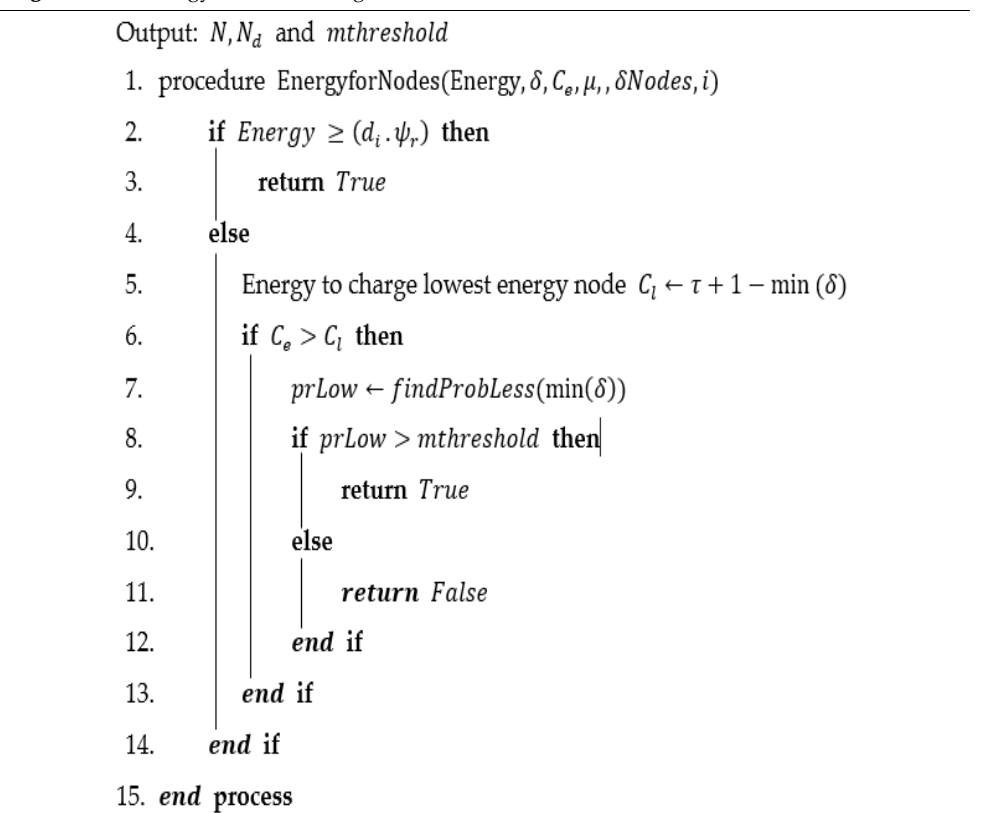
Algorithm 3 : Energy for Nodes’ Algorithm Algorithm 3: Energy for Nodes’ Algorithm